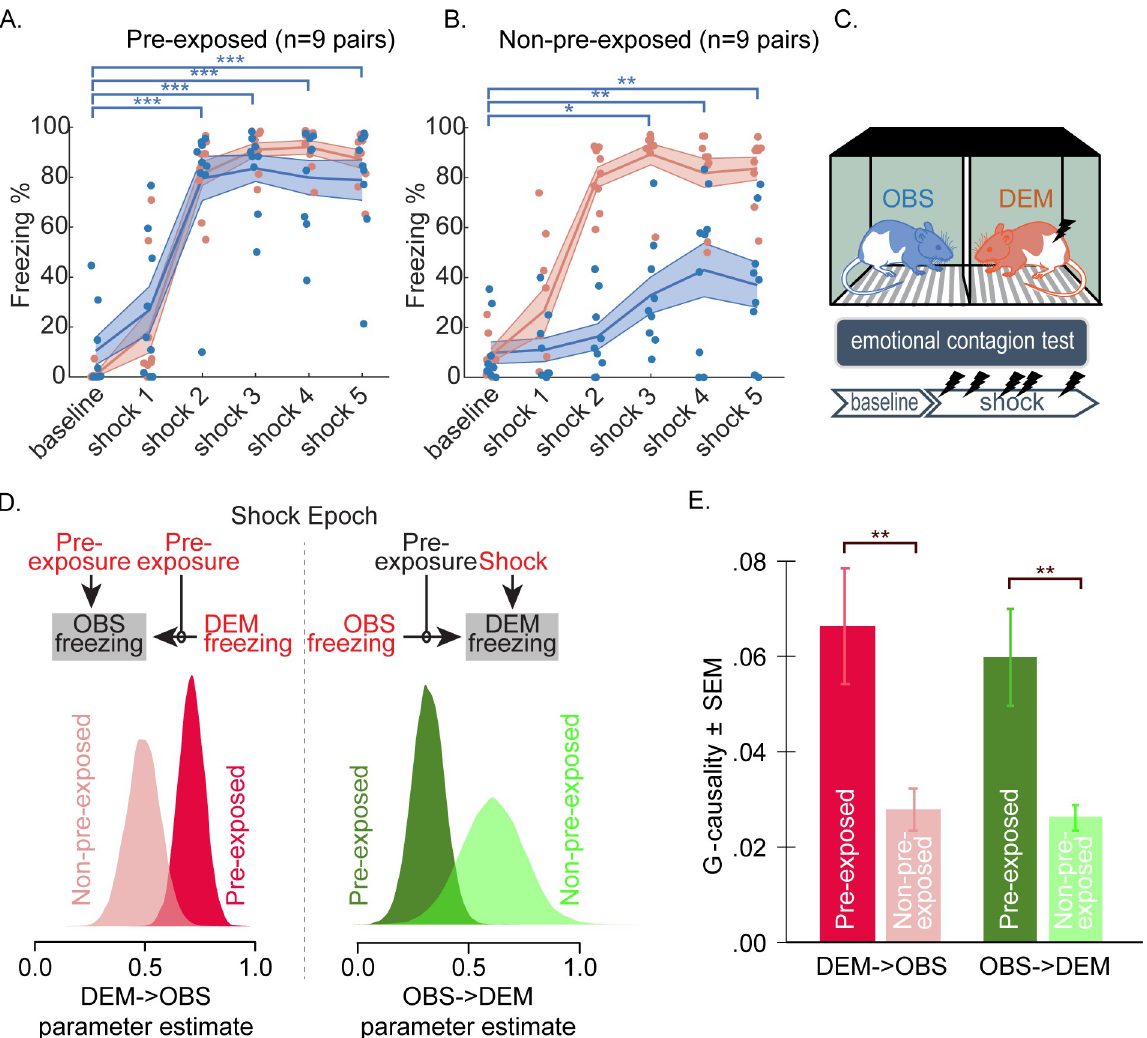
Fig 8. Effect of shock preexposure. (A) Freezing levels for nine preexposed dyads taken from the 3-week group of the individual familiarity experiment for the baseline period and following each of the five shocks. Mean and SEM are shown separately for the demonstrators (orange) and observers (blue). (B) Same for nine other dyads in which the observer rat was not preexposed to shocks prior to the interaction test. For the observers, the significance of one-tailed paired-samples t test for freezing following each shock compared with baseline is shown in blue where significant ( � :p unc < 0.05, �� :p unc < 0.01, ��� :p unc < 0.001). Each animal is shown as a dot. (C) Schematic of the interaction test with the two rats color coded as in panels A and B. (D) Parameter estimates from the Bayesian model calculated over the shock period. The variables used for modeling the observer freezing are shown on the left, and those for modeling the demonstrator freezing are shown on the right. Variables that improved the model are shown in red. The effect of preexposure is shown underneath each model as the posterior distribution of the parameter estimates for the connection between DEM ! OBS freezing (left) and OBS ! DEM (right) separately for the preexposed and nonpreexposed pairs. Note that to improve the estimate for the preexposed animals, here we included all 32 preexposed rats from the individual familiarity experiment (because weeks of familiarity did not influence this parameter significantly), whereas for the nonpreexposed pairs, we have n = 9. (E) G-causality F values as a function of direction and preexposure. �� : two-tailed t test, p < 0.01. Data can be found at http://dx.doi.org/10.17632/ h8fkyr2z35.1. DEM, demonstrator rat; G-causality, Granger causality; OBS, observer rat; SEM, standard error of the